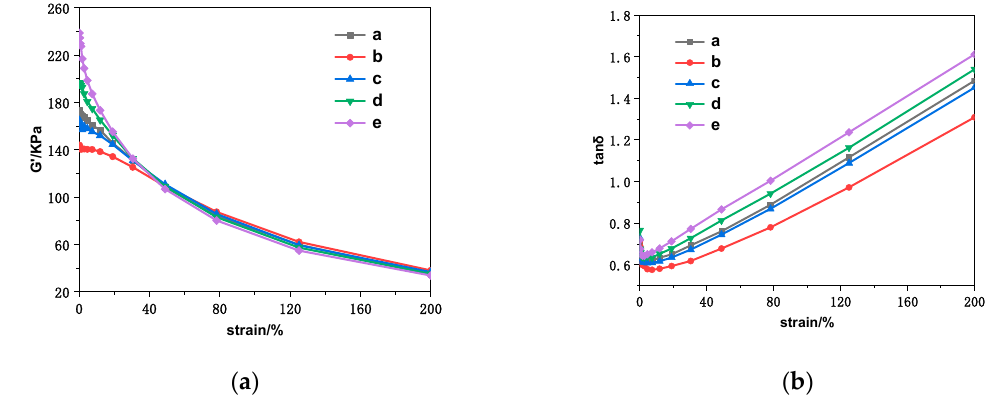
Figure 4. ( a ) Storage modulus (G’) and ( b ) loss factor (tan δ ) versus strain for SSC@NR composites.